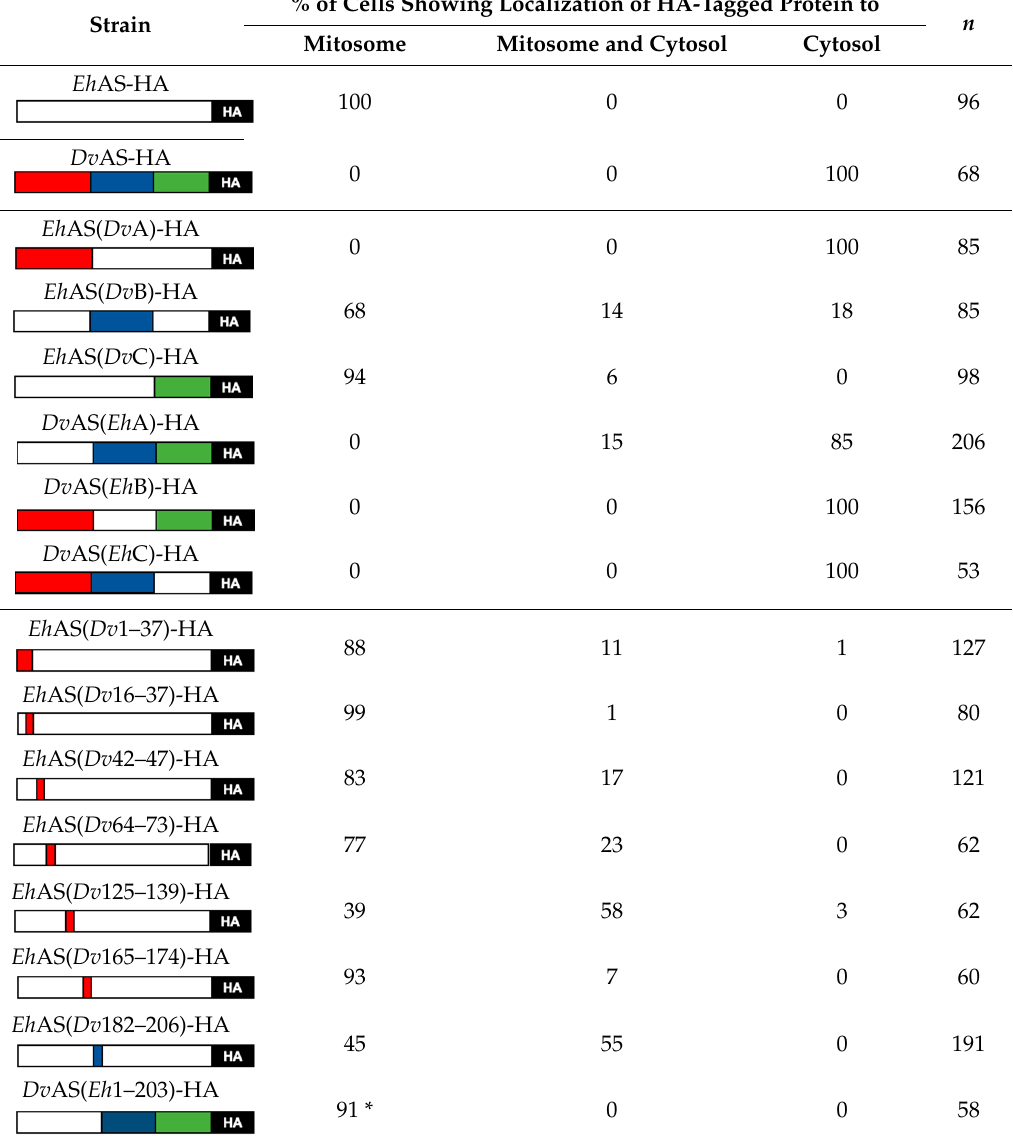
antisera (cytosol marker, bottom panel), respectively. Table 1. Percentage of cells expressing various HA-tagged proteins that display mitosome, mitosome Table 1. Percentage of cells expressing various HA-tagged proteins that display mitosome, mitosome Table 1. Percentage of cells expressing various HA-tagged proteins that display mitosome, mitosome Table 1. Percentage of cells expressing various HA-tagged proteins that display mitosome, mitosome Table 1. Percentage of cells expressing various HA-tagged proteins that display mitosome, mitosome and cytosol, and cytosol localization. and cytosol, and cytosol localization. and cytosol, and cytosol localization. and cytosol, and cytosol and cytosol, and cytosol localization.